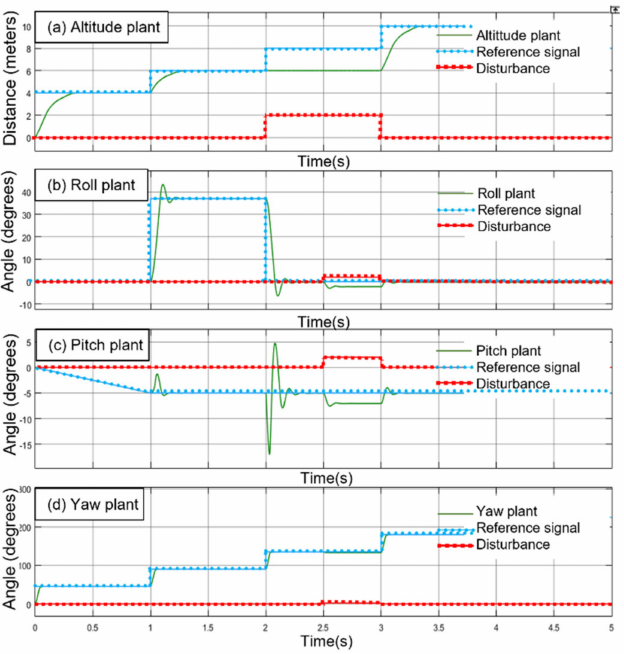
Figure 16. Sugeno Fuzzy–PD simulation results. ( a ) Altitude plant, ( b ) roll plant, ( c ) pitch plant, ( d ) yaw